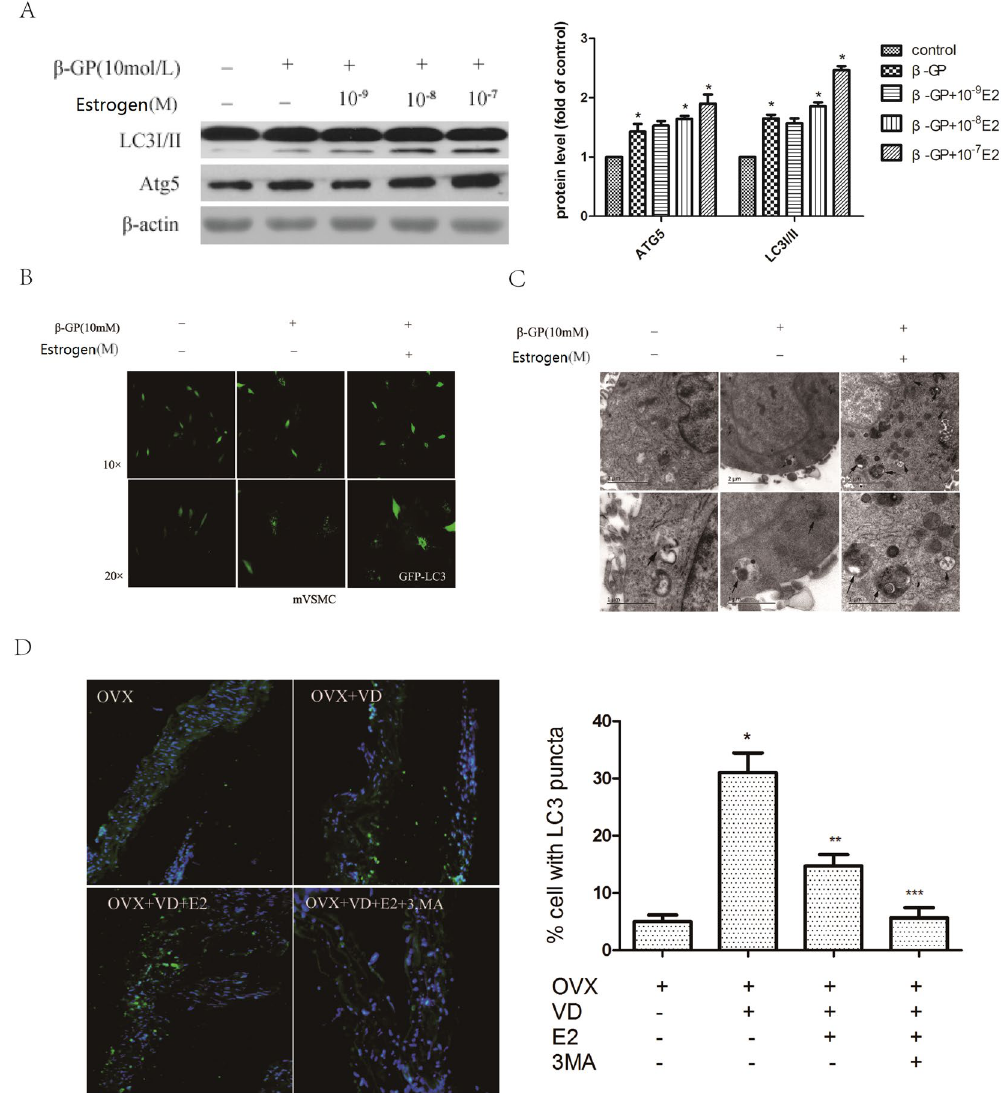
Figure 4. Oestrogen increases the level of autophagy during the osteoblastic differentiation of VSMCs and in calcified arteries. ( A ) Western blot analysis of LC3I/II and Atg5 levels in VSMCs treated with different concentrations of oestrogen for 72 h (n = 5). ( B ) Confocal microscopy of green fluorescent protein (GFP) in VSMCs transiently transfected with GFP-LC3 plasmids cultured for 48 h and then treated with oestrogen for 72 h; autophagosomes are indicated by fluorescent puncta. ( C ) VSMCs were incubated with oestrogen for 72 h and then analysed by electron microscopy. A representative image is shown. The autophagic vacuoles containing organelle remnants are highlighted by arrows (n = 5). ( D ) Immunofluorescence analysis of LC3 puncta in the aorta from four mice subjected to different treatments: OVX mice treated with vitamin D3, vitamin D3 + oestrogen, vitamin D3 + oestrogen + 3MA or 7% emulphor (control) (n = 8). * p < 0.01 compared with the OVX groups. ** p < 0.01 compared with OVX + VD group. *** p < 0.01 compared with OVX + VD + E2 group. Representative images are